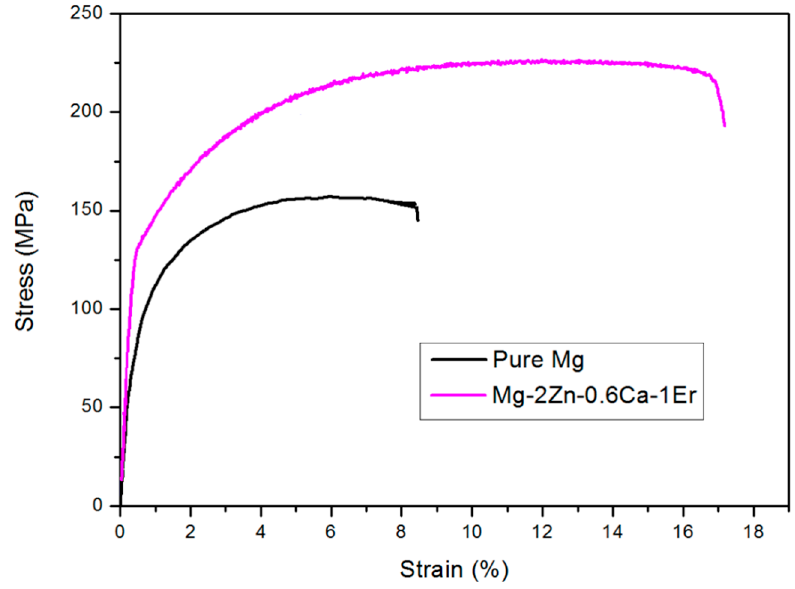
Figure 6. Representative tensile curves of pure Mg and Mg-2Zn-0.6Ca-1Er. Table 2. Tensile properties of pure Mg and Mg-2Zn-0.6Ca-1Er. Sl.